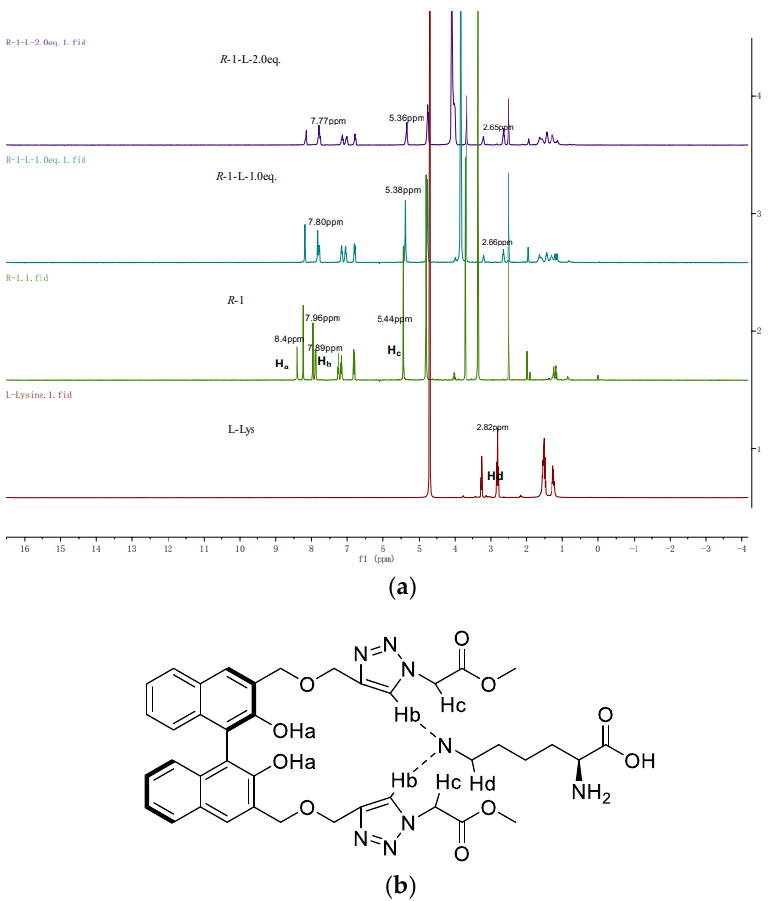
Figure 4. ( a ) 1 H NMR spectra of the mixture of R - 1 with varying equivalent of L -Lys in a mixed solvent of DMSO/D 2 O (10/1); ( b ) structural analysis of R - 1 and L -Lys.